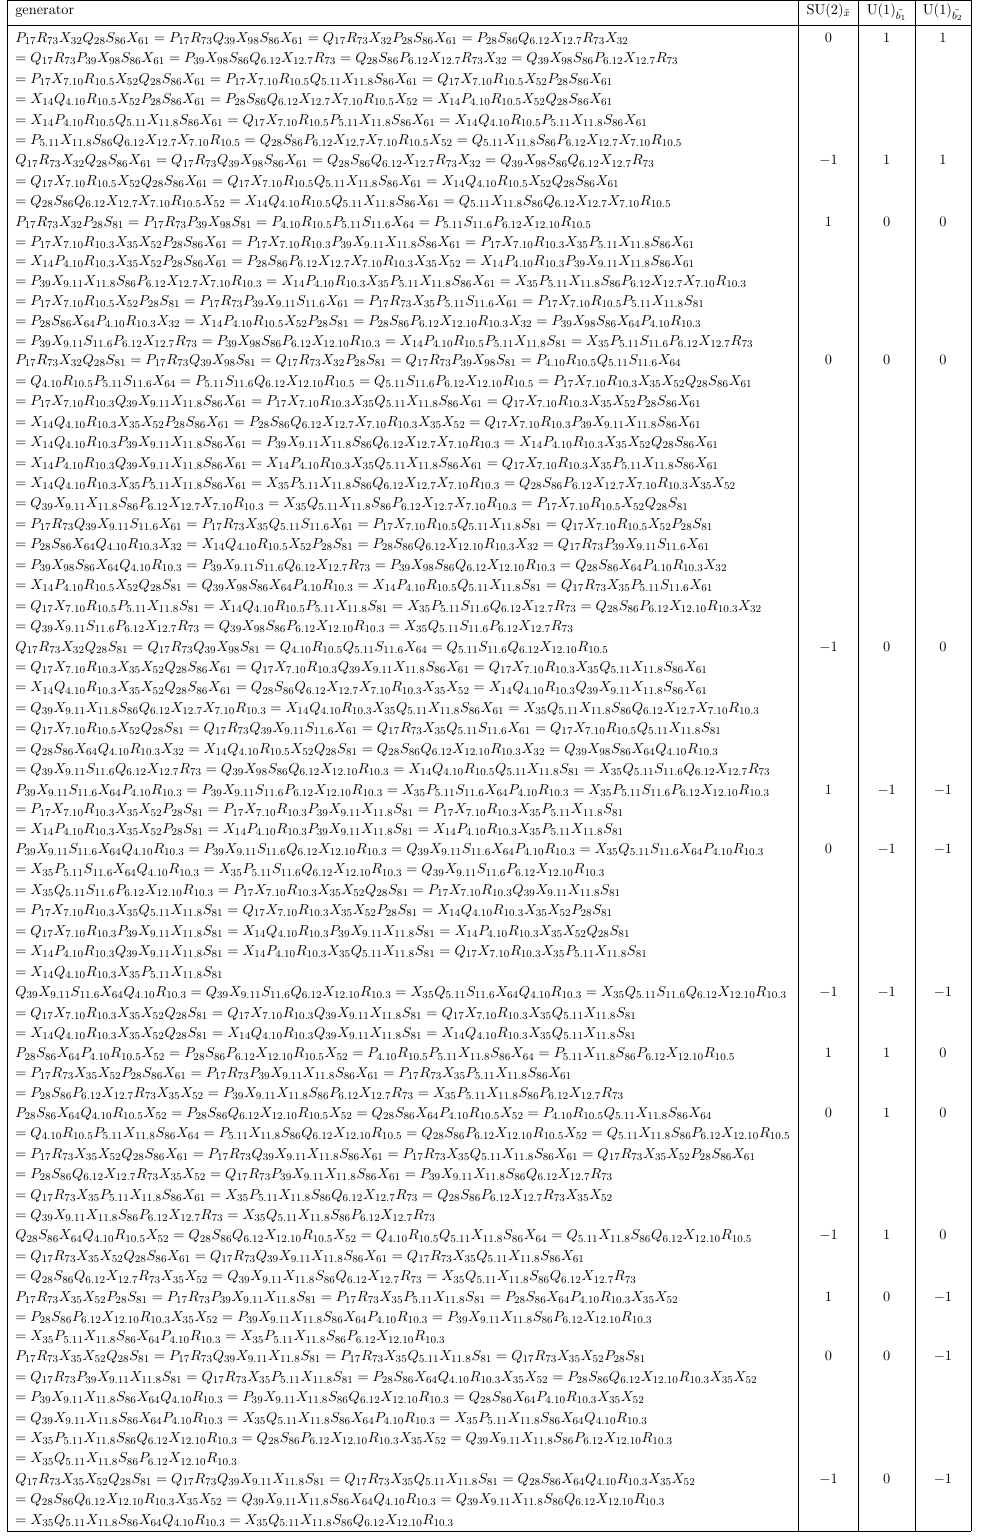
Table 70 . The generators in terms of bifundamental chiral fields for Model 17 (Part 2)